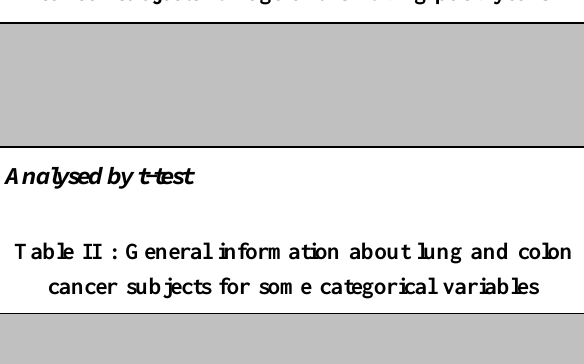
Table I : General information about lung and colon cancer subjects for age and smoking pack years